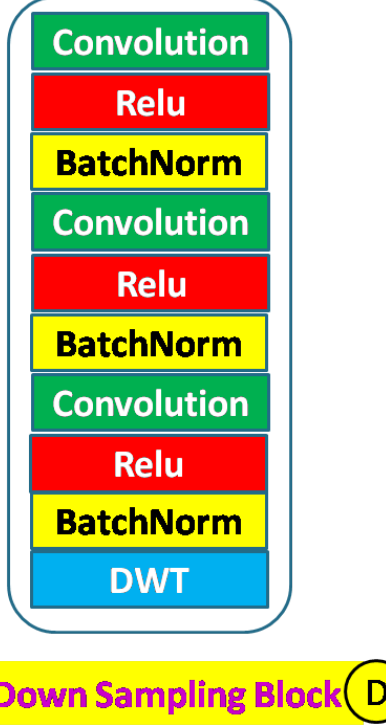
Figure 4. Down–sampling block details: The stack of convolution operators and the sequence of Batch–Norm and activation layers are